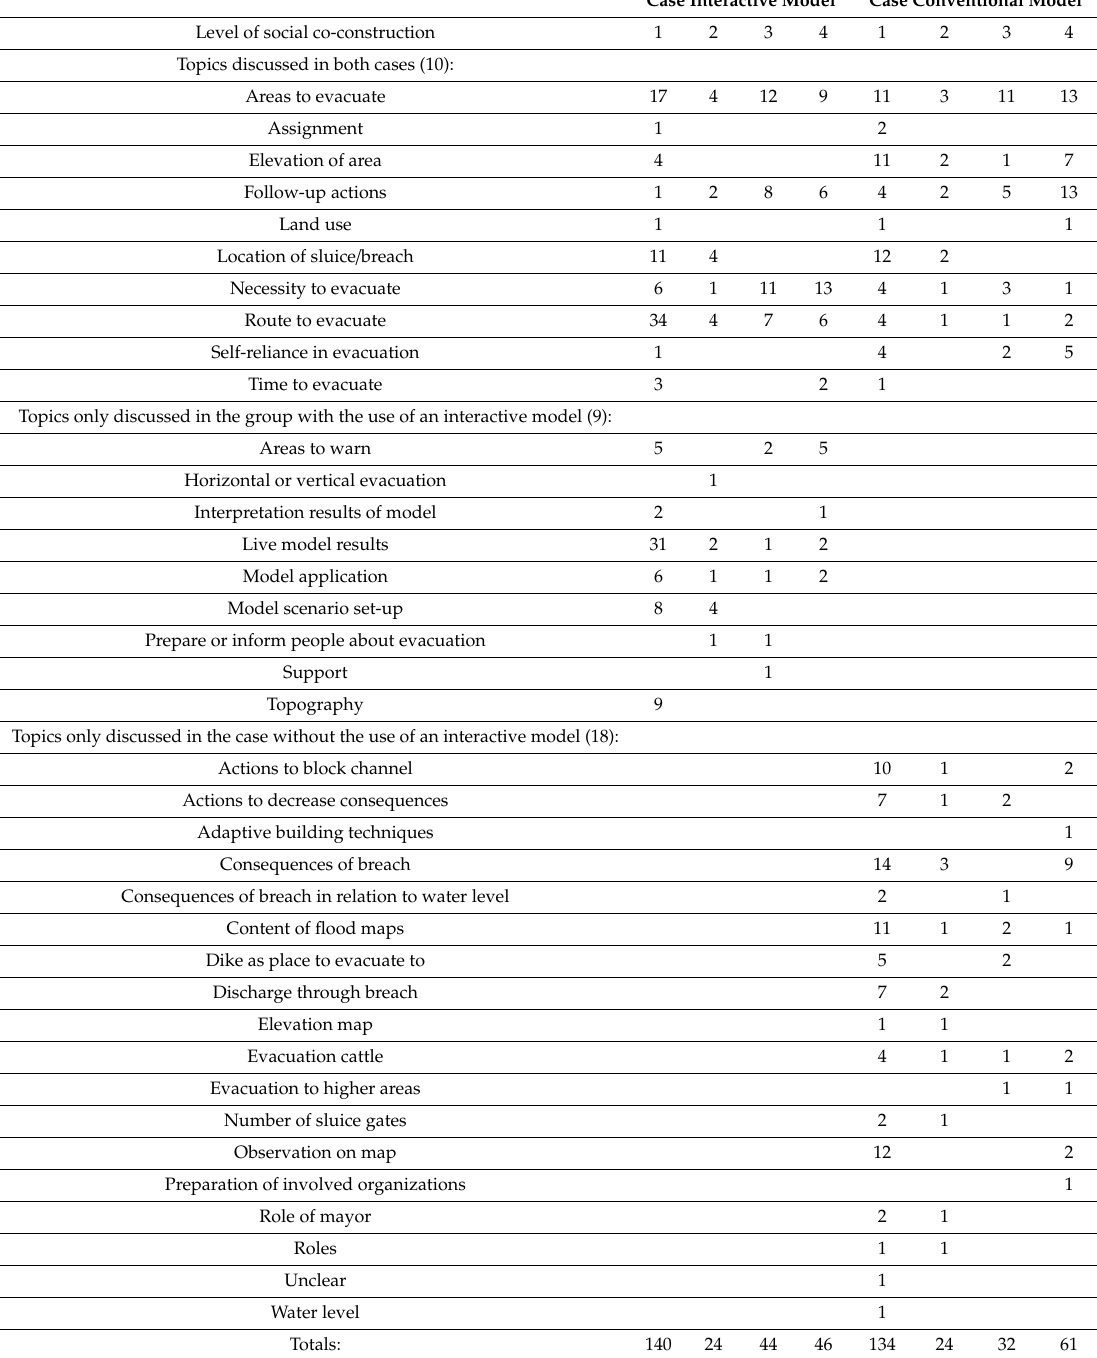
Table 4. Indicator 4: The degree in which the discussed topics where socially co-constructed. This was measured by the number of statements per topic, sorted by the four di ff erent levels of social co-construction. To make sure that the statements were in fact part of a shared knowledge construction process, they were only counted if they were a response on earlier statements and had had full attention of the group. Note that the total number of statements is slightly di ff erent from the total number of statements in Table 3 because a few statements per case could not be clearly classified in one of the categories of social